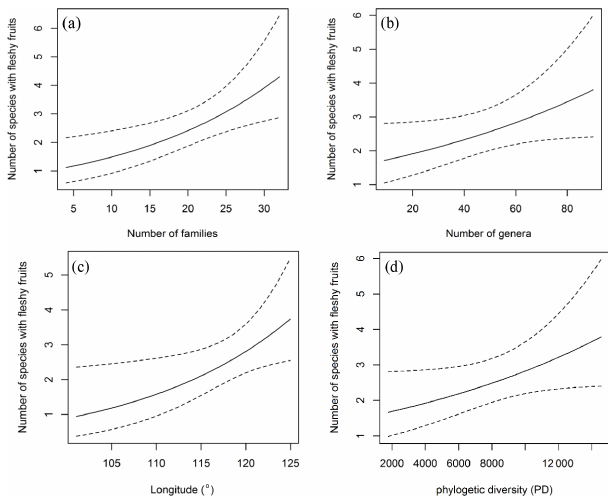
Figure 5. Relationships between the number of species with fleshy fruits and longitude (a) , number of families and genera (b, c) as well as phylogenetic diversity (d) . The number of species with fleshy fruits increases as longitude increases. But it does not have a signif- icant relationship with phylogenetic diversity ( p > 0 .